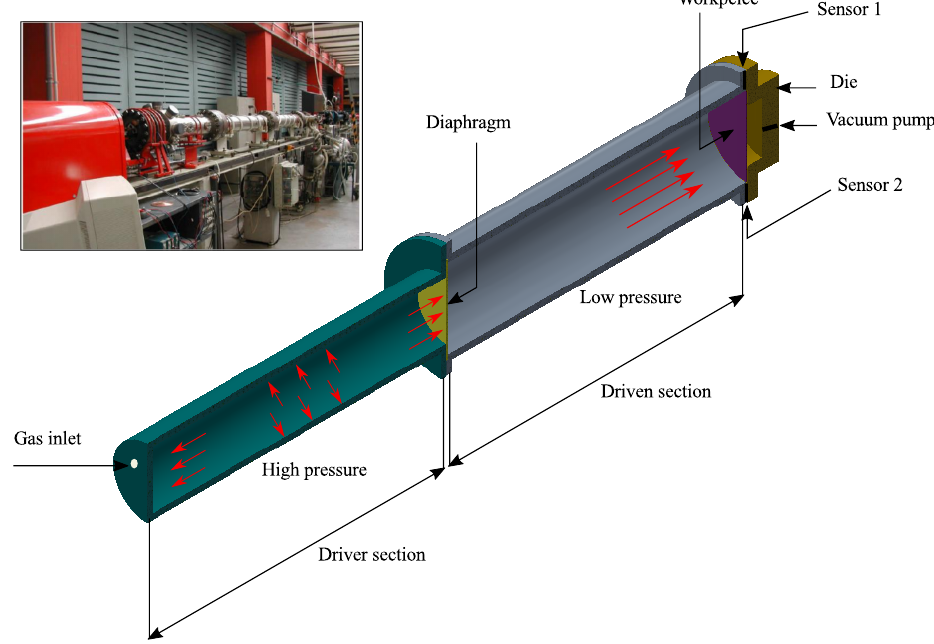
Figure 1. A schematic representation the experimental setup of the shock wave tube forming process. Inset: The shock tube facility at the Institute of General Mechanics, RWTH Aachen